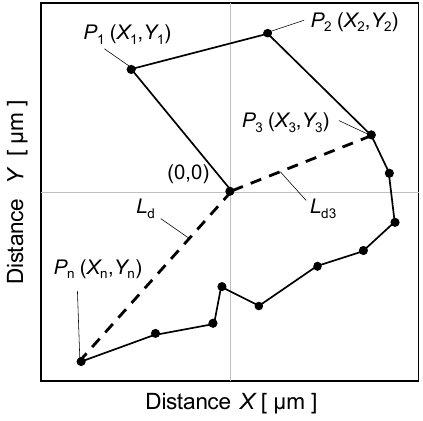
Figure 15. Definition of L p and L d .